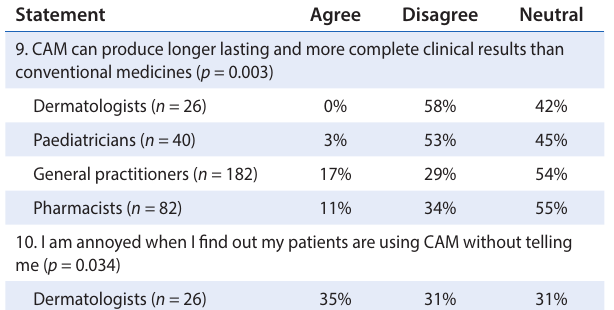
Table 2: South African healthcare professionals’ familiarity regarding CAM CAM therapy Unfamiliar Slightly